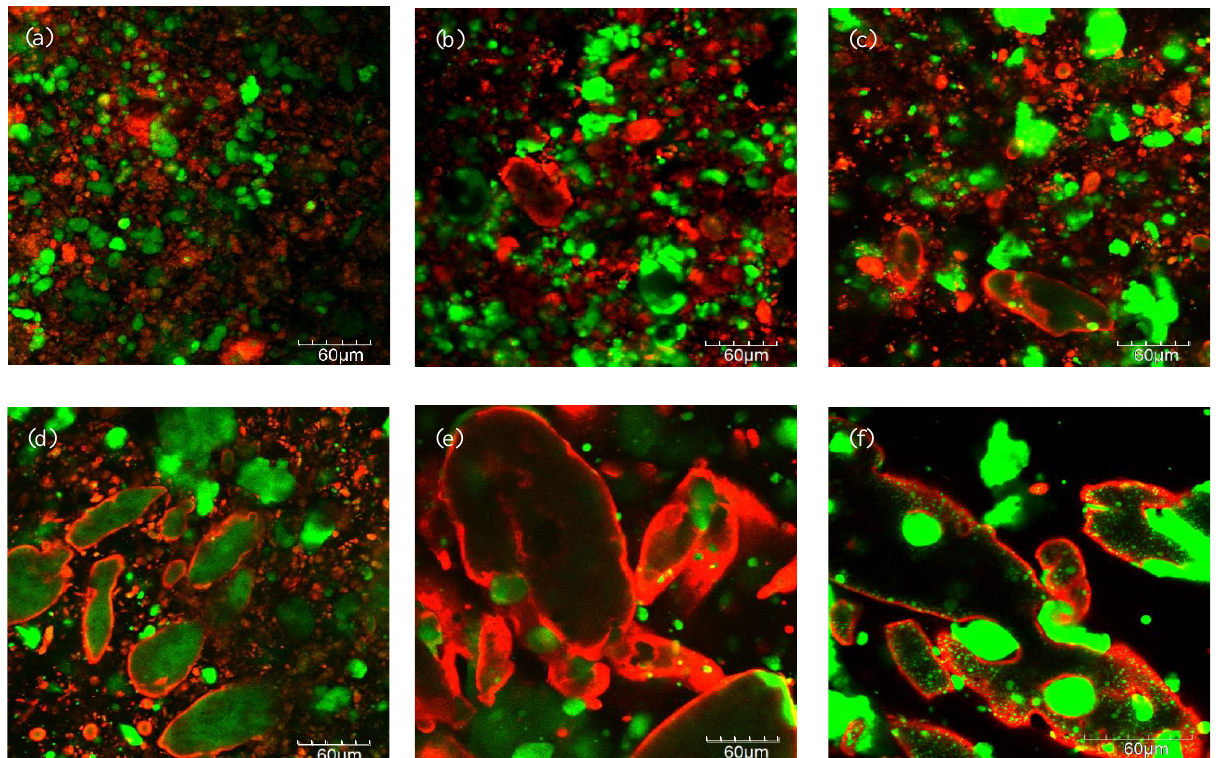
Figure 3. Confocal laser scanning microscopy images of the plant-based cheese alternative samples, 0Z-100C ( a ), 25Z-75C ( b ), 50Z-50C ( c ), 75Z-25C ( d ) and 100Z-0C ( e ), at 40×. Microstructure of 100Z-100C ( f ) at 60× is also shown. Fat and protein are represented by green and red, respectively.